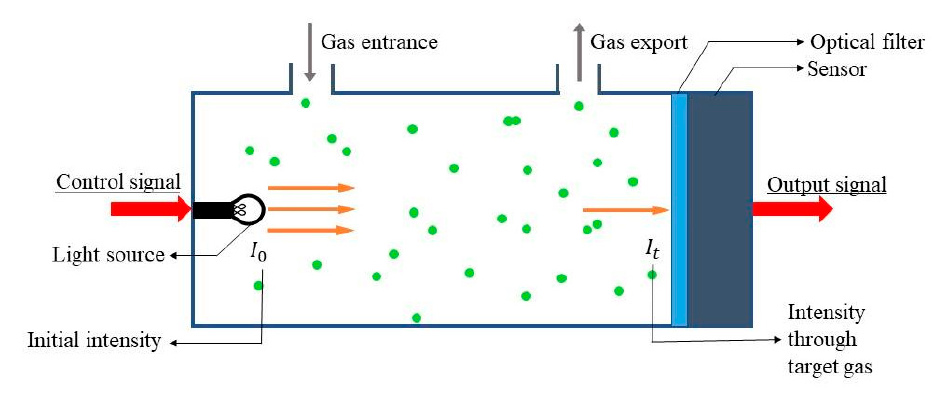
Figure 1. Gas detection by infrared absorption spectroscopy.